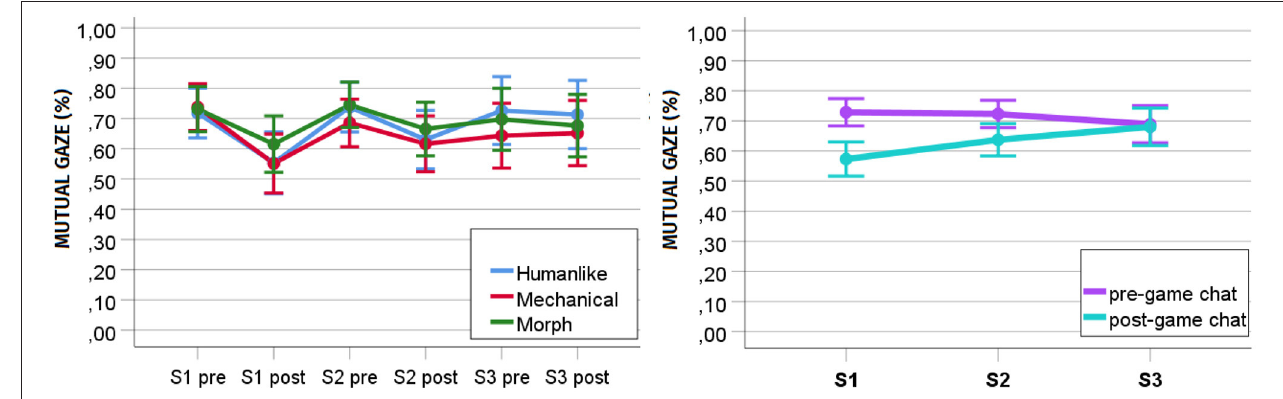
FIGURE 6 | Development of percentage of mutual gaze in the pre and post-game social chats over repeated sessions. On the left, the development of mutual gaze in the pre and post-game social chat for each level of the robot’s humanlikeness. On the right, the overall change. S1, Session 1; S2, Session 2; S3, Session 3.